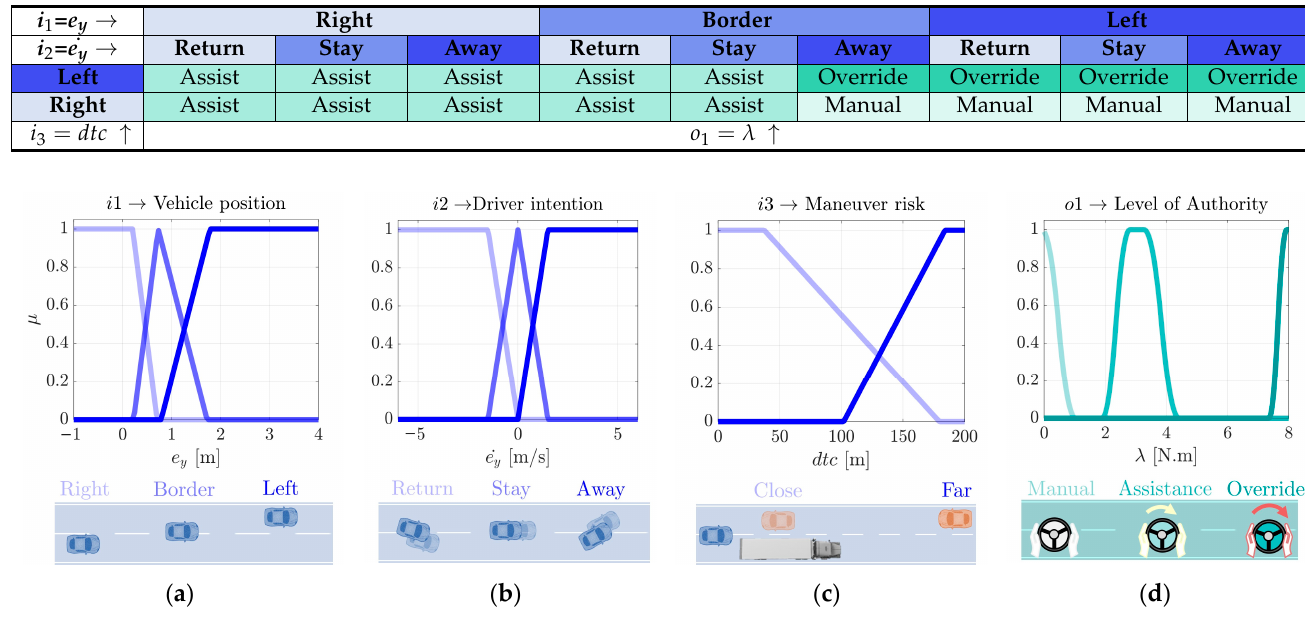
Figure 8. Fuzzy logic membership functions of arbitration module: ( a ) input 1 is the lateral error with respect to the right lane, ( b ) input 2 is the derivative of the lateral error and combined with input 1 helps to detect the driver lane change intention, ( c ) input 3 represents the risk of the maneuver, ( d ) the output of the arbitration system, which decides based on the three inputs, if the steering assistance is null (Manual), enough to help (Assistance) or strong enough to avoid the driver maneuver (Override). The fuzzy output is then proportionally combined with the normalized field of view of the ego vehicle, to consider the automation perception capability within the